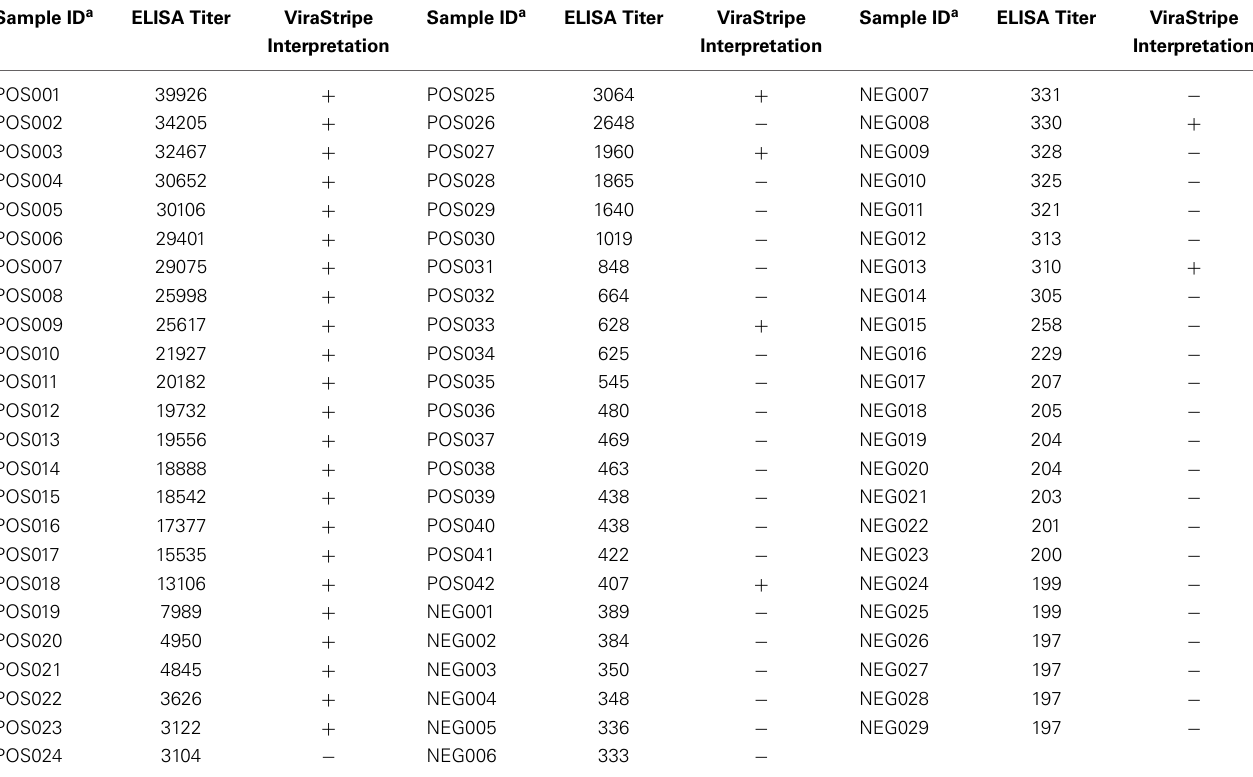
a Of the 71 dog serum samples tested by ViraStripe, the 42 that had an ELISA titer above 400 were designated POS001-042, and the 29 that had an ELISA titer below 400 were designated